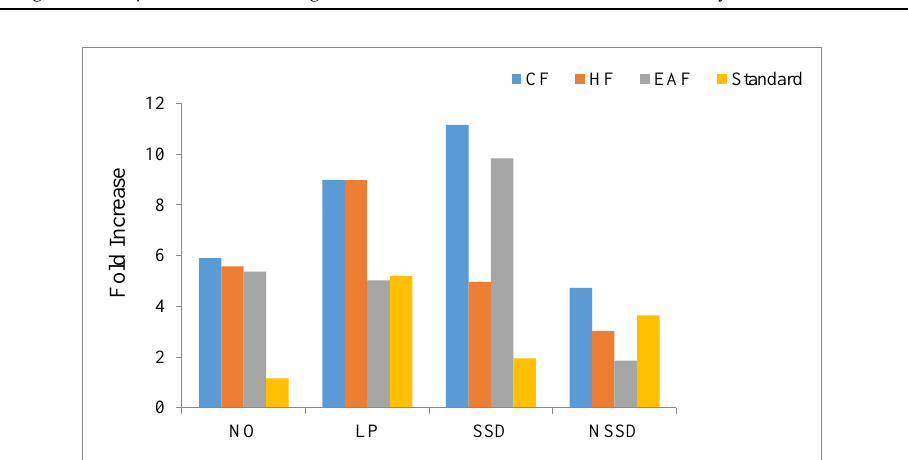
ANOVA = Analysis of variance